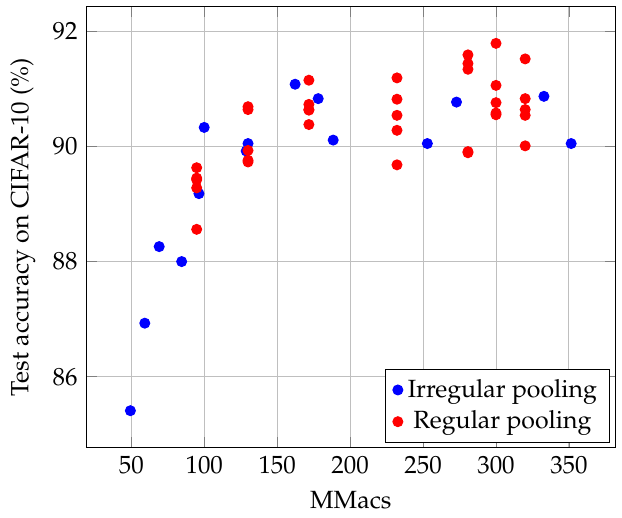
Figure 3. Accuracy on CIFAR-10 of various ThriftyNets of 40 k parameters, as a function of the number of Macs they perform. In blue, the points are obtained by considering the irregular spacing of downsamplings. In red, the points are obtained by varying the number of iterations, while maintaining a regular spacing between downsamplings.